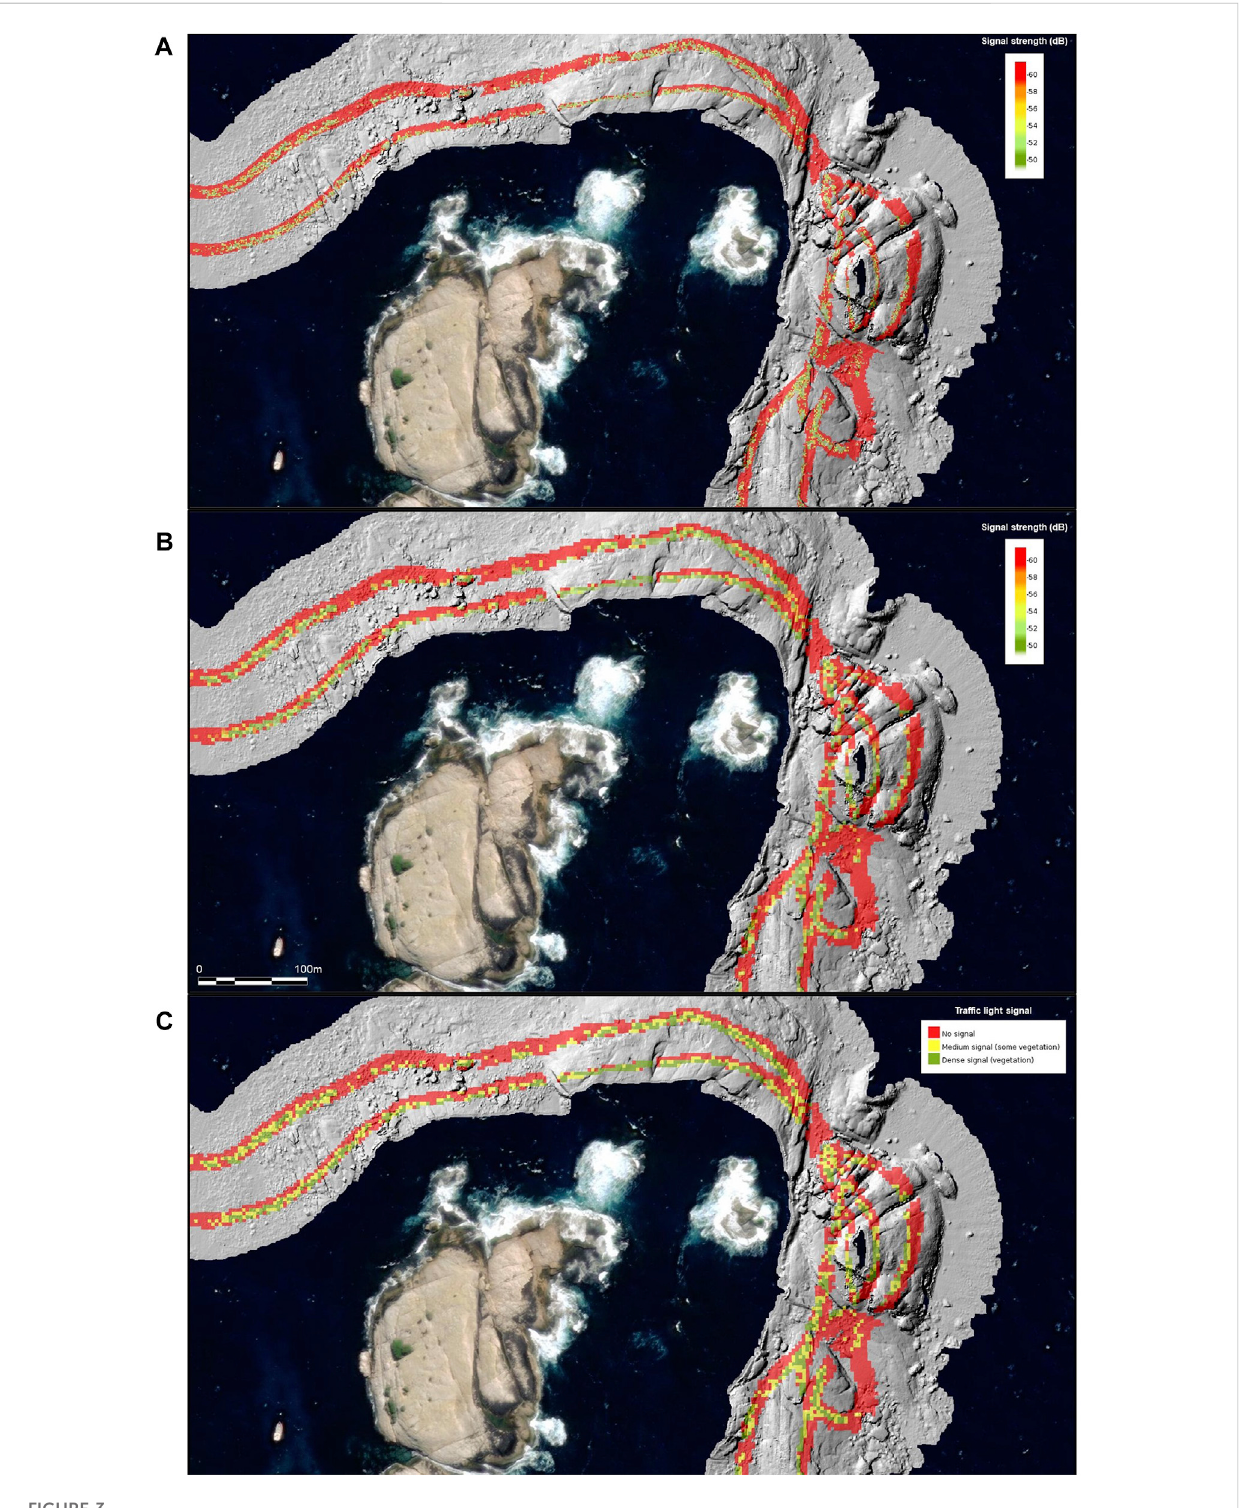
FIGURE 3 WaterColumnData(WCD)overlaidon50 cmhillshadeatGovernorIslandMarineReserve.Panelsshow: (A) WCD1 m 2 continuoussurface; (B) WCD 9 m 2 mean signal; and (C) thresholded vegetation likelihood “ traf fi c light signal.